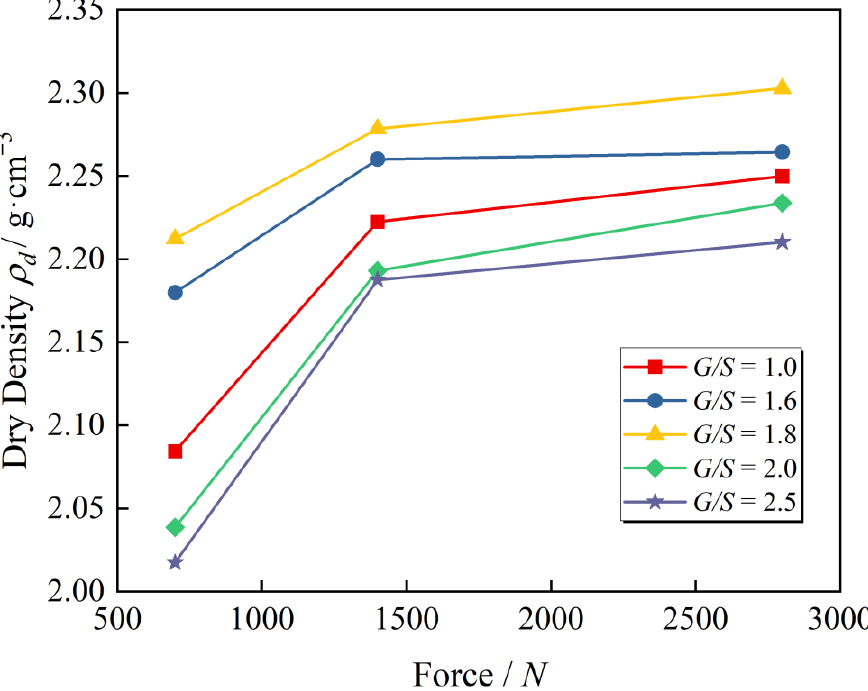
Figure 7. The curves of achieved dry density versus vibratory force from laboratory plate vibration compaction tests.